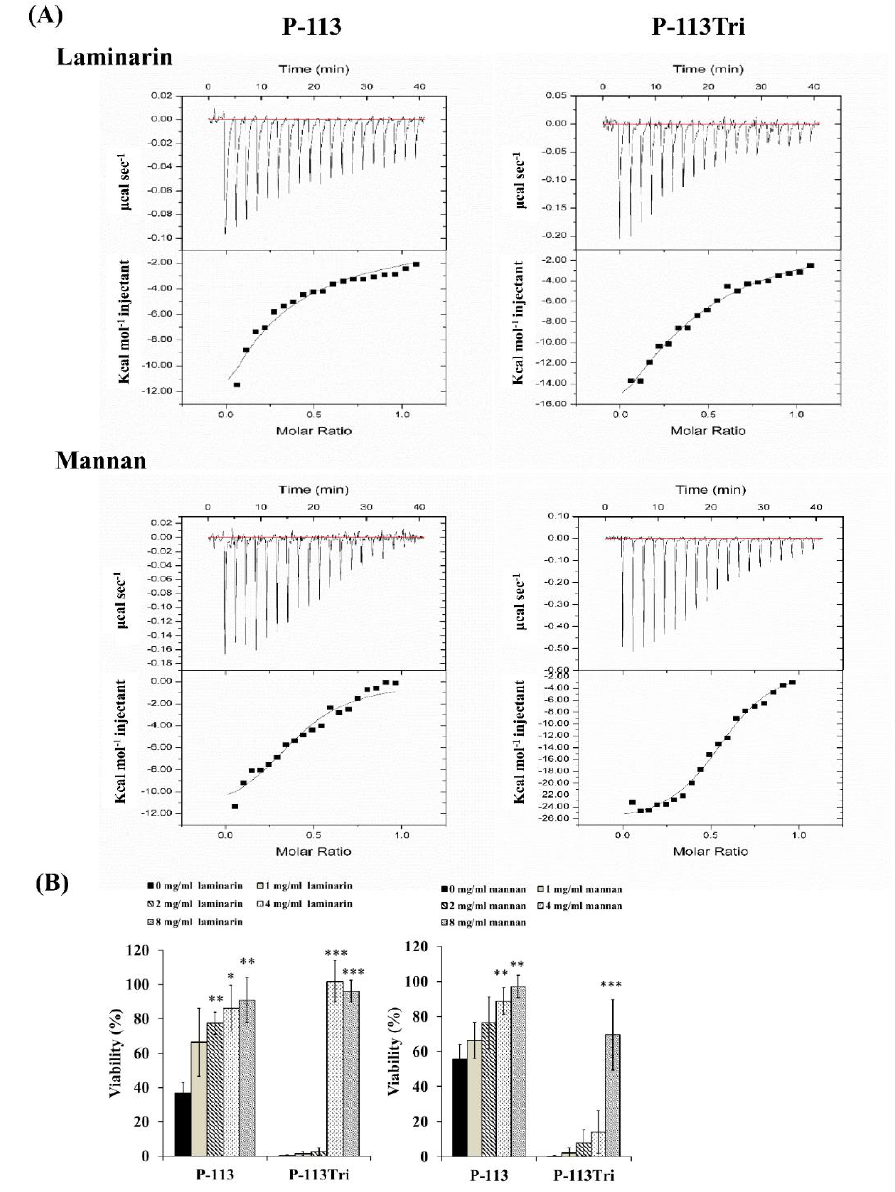
Figure 3. P-113 and P-113Tri bind to mannan and laminarin. ( A ) The interaction of the peptides with mannan and laminarin was measured by isothermal titration calorimetry (ITC). ( B ) Viability of C . albicans cells treated with different concentrations of mannan and laminarin and the peptides (12 μg/mL).